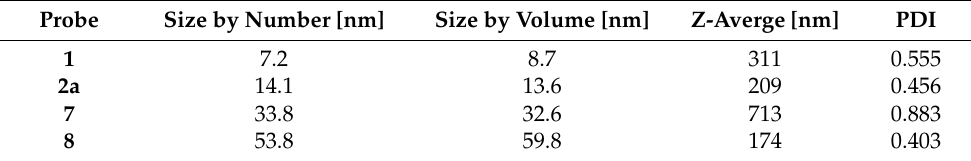
Table 2. Different expressions of the hydrodynamic radius of the AuNPs measured by